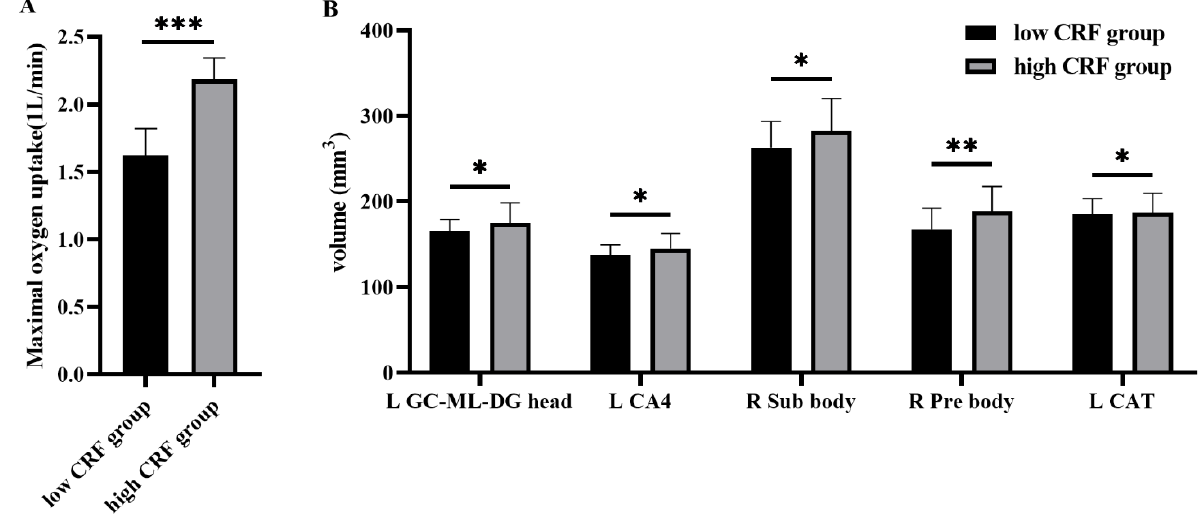
Figure 3. ( A ) The difference in maximal oxygen uptake between the two groups; ( B ) Differences between the hippocampal and amygdala subfields. L, left hemisphere; R, right hemisphere; CRF, cardiorespiratory fitness; GC-ML-DG head: granule cell layers of the dentate gyrus; CA4: cornuam- monis 4; Sub body: subiculum body; Pre body: presubiculum body; CAT: corticoamygdaloid tran-